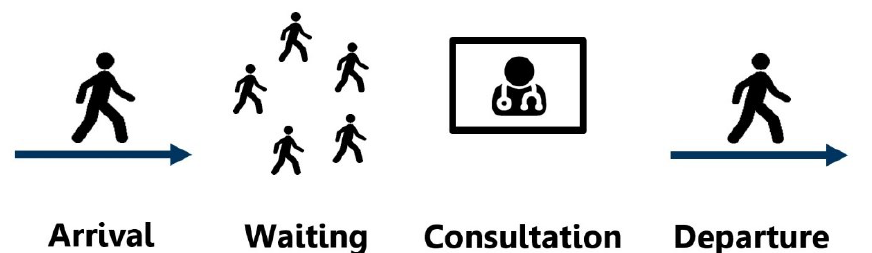
Figure 1. A queuing system in a general practice has three key components: arrival process, services (physician consultation and idle time), and queuing discipline (treatment order, e.g., as scheduled with/without emergency patients).